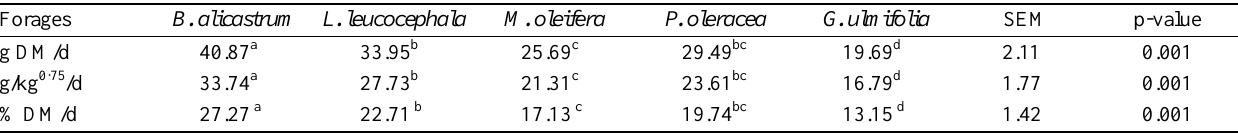
Table 4. DMI of the five forages offered separately (n = 12 rabbits for each mean)